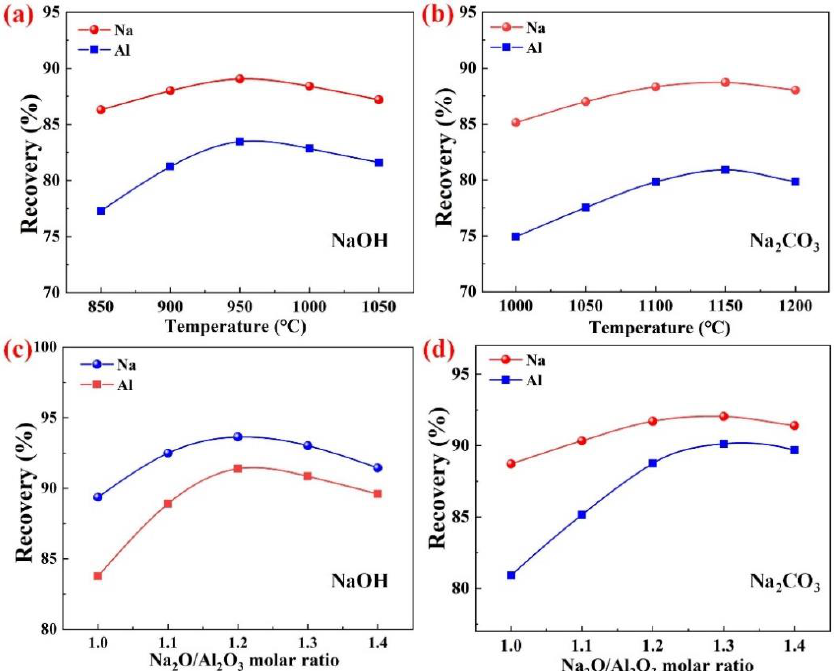
Figure 5. Recovery of Al and Na in roasting clinkers under different roasting conditions: roasting